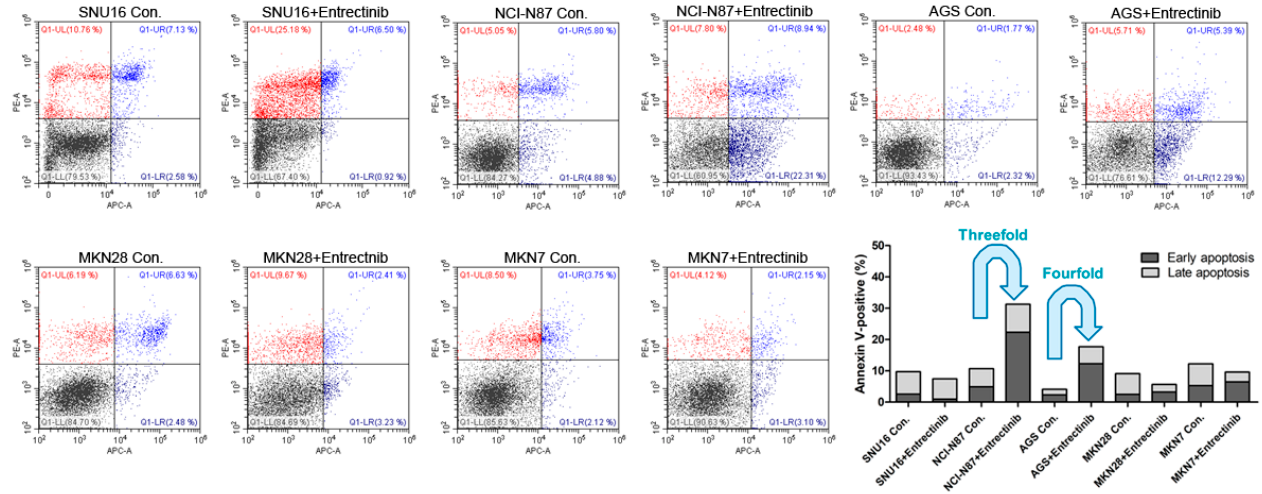
Figure 4. Effects of neurotrophic receptor tyrosine kinase (NTRK) inhibitors on gastric cancer cells with or without NTRK gene expression. SNU16, NCI-N87, AGS, MKN28, and MKN7 cells were treated with 10 μ M concentrations of NTRK inhibitors for 48 h.